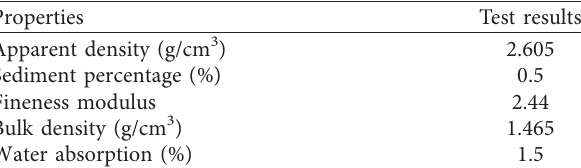
Table 3: Properties of fine aggregate.